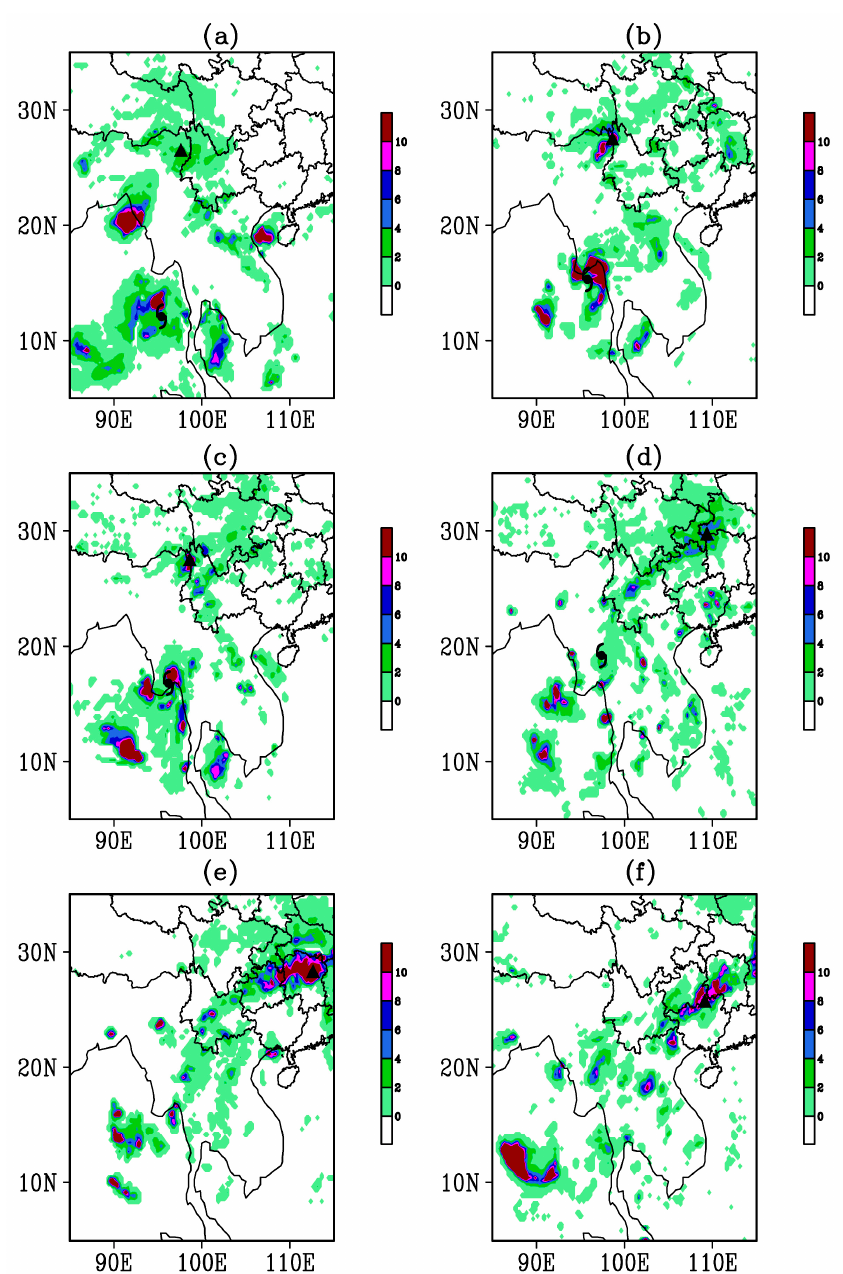
Figure 3. Tropical Rainfall Measuring Mission satellite-based precipitation (units: mm 3 h − 1 ) from 11 to 13 May 2002. ( a ) 00:00 on 11 May 2002, ( b ) 21:00 on 11 May 2002, ( c ) 00:00 on 12 May 2002, ( d ) 12:00 on 12 May 2002, ( e ) 21:00 on 12 May 2002, and ( f ) 15:00 on 13 May 2002. The locations of the tropical cyclone are indicated by black tropical storm symbols. The centers of maximum precipitation are indicated by black triangles.